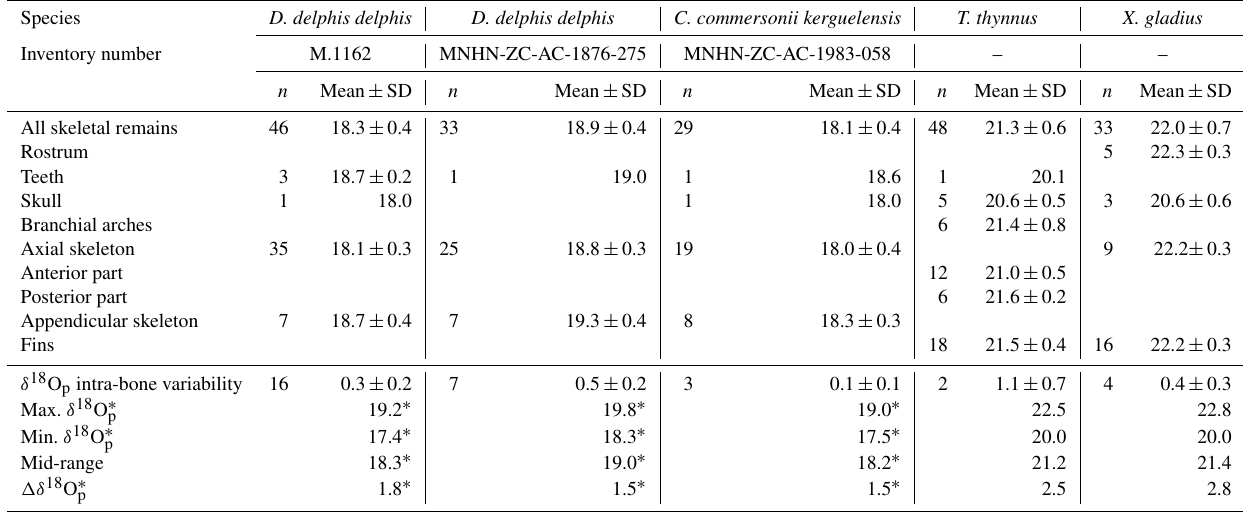
Table 1. Summary of the mean oxygen isotopic composition (‰, V-SMOW) of dolphins and osteichthyans.